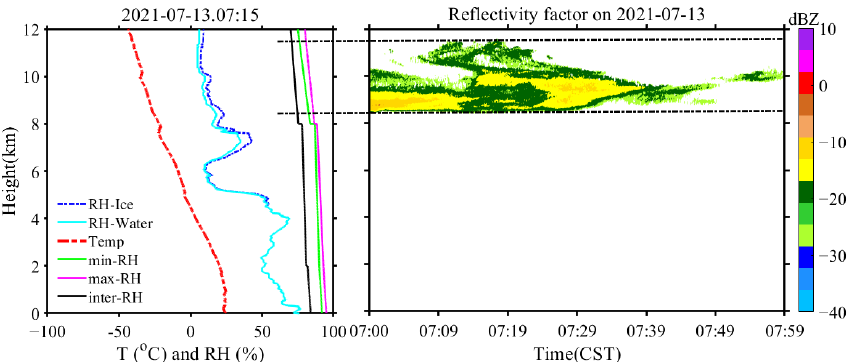
Figure 4. High cloud detected by the radiosonde and MMCR on 13 July 2021 (radiosonde temperature and RH profile ( left ), reflectivity factor THI from the MMCR ( right )).